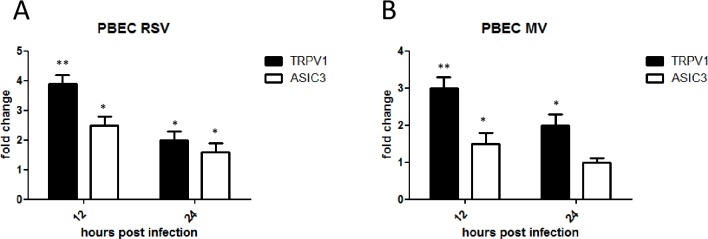
RSV and MV infection induce TRPV1 and ASIC3 mRNA up-regulation in PBEC.PBEC were infected with RSV (MOI 0.1) and MV (MOI 1). TRPV1 and ASIC3 mRNA levels were determined by qRT-PCR at 12 and 24 hpi. (A) RSV), (B) MV. Fold change was determined relative to uninfected/untreated cells.